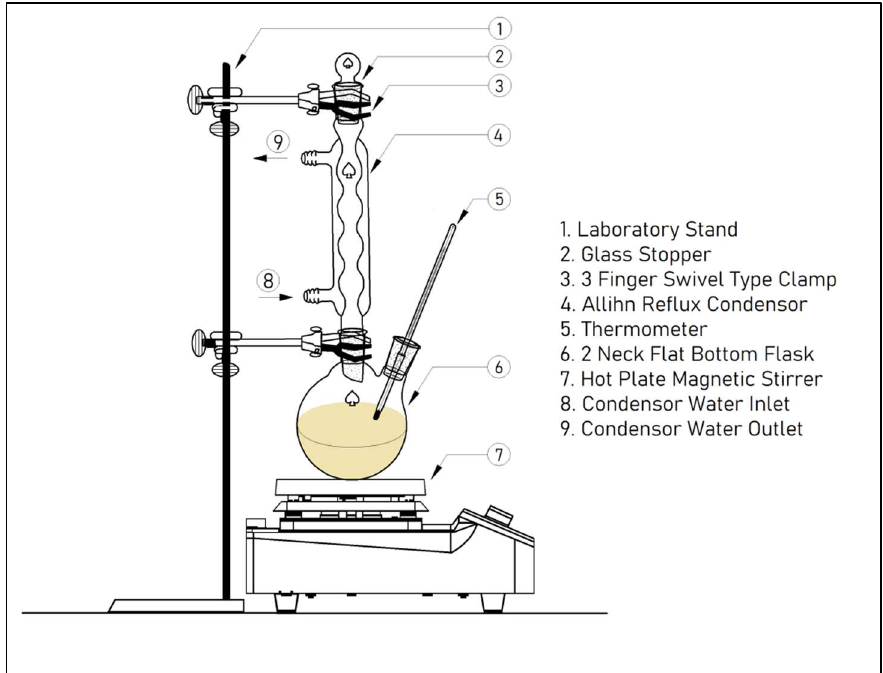
Figure 1. Schematic representation of the biodiesel production setup [34].